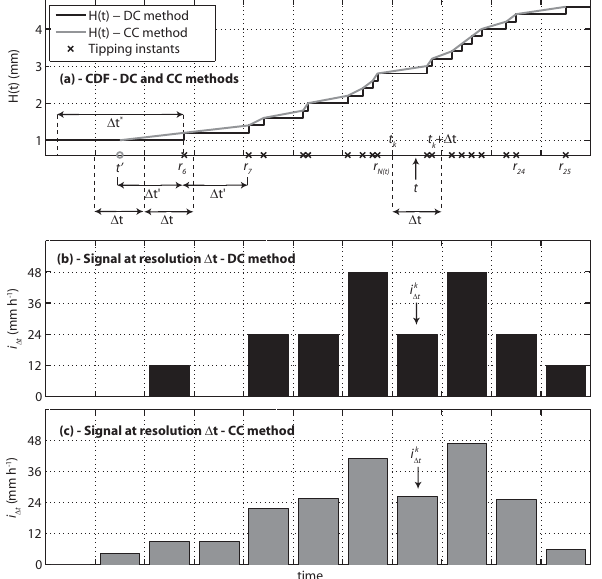
rainfall intensity signal with discrete counting (DC) and continu- ous counting (CC) methods. (a) Cumulative rainfall depth function H(t) of the rainfall signal built with DC and CC methods: the sym- bols are described in Appendix A. (b) Rainfall intensity signal at resolution 1t built with the DC method. (c) Same as (b) but for CC. The values reported on the y-axis refer to the case of 1t =1min and an accumulated rainfall depth per tip of